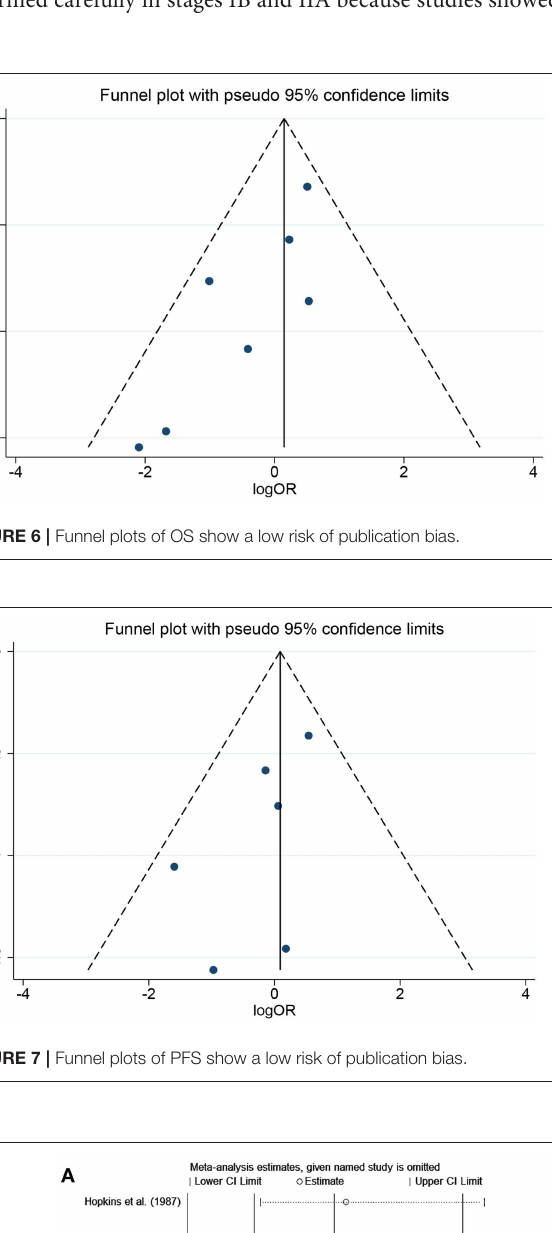
Frontiers in Oncology |